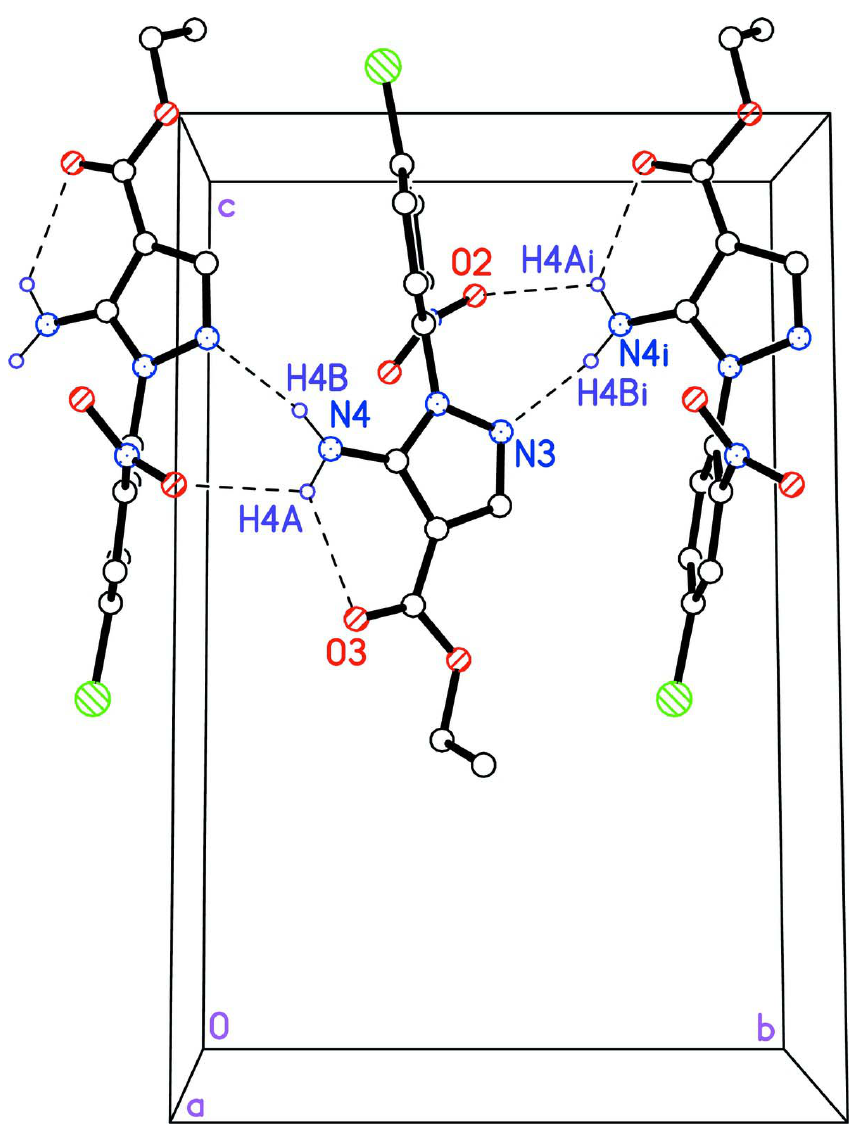
Perspective view of the crystal packing showing hydrogen-bond interactions (dashed lines). H atoms not involved in hydrogen bonding have been omitted for clarity. Symmetry operator i = - x + 1/2, y - 1/2, - z + 3/2. Ethyl 1-(4-chloro-2-nitrophenyl)-5-nitro-4, 5-dihydro-1 H